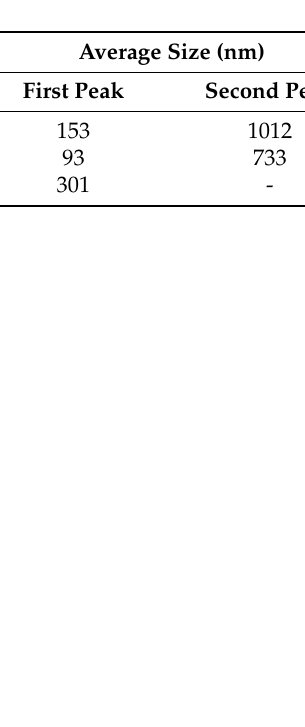
Table 1. Size distribution of ZVI particles.